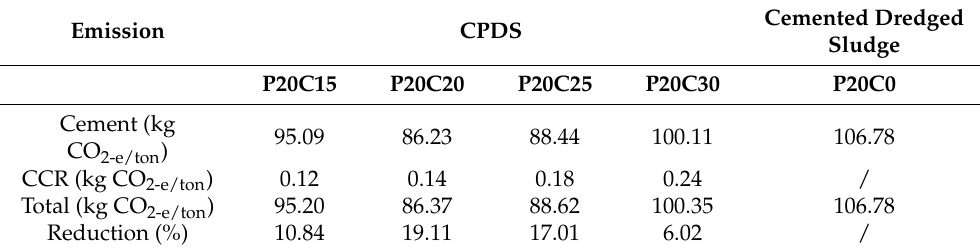
Figure 15. Total CO 2-e of CPDS (P20C15, P20C20, P20C25 and P20C30) and cemented dredged sludge. Table 5. The emission and reduction of CPDS for per ton of dry soil at 800 kPa